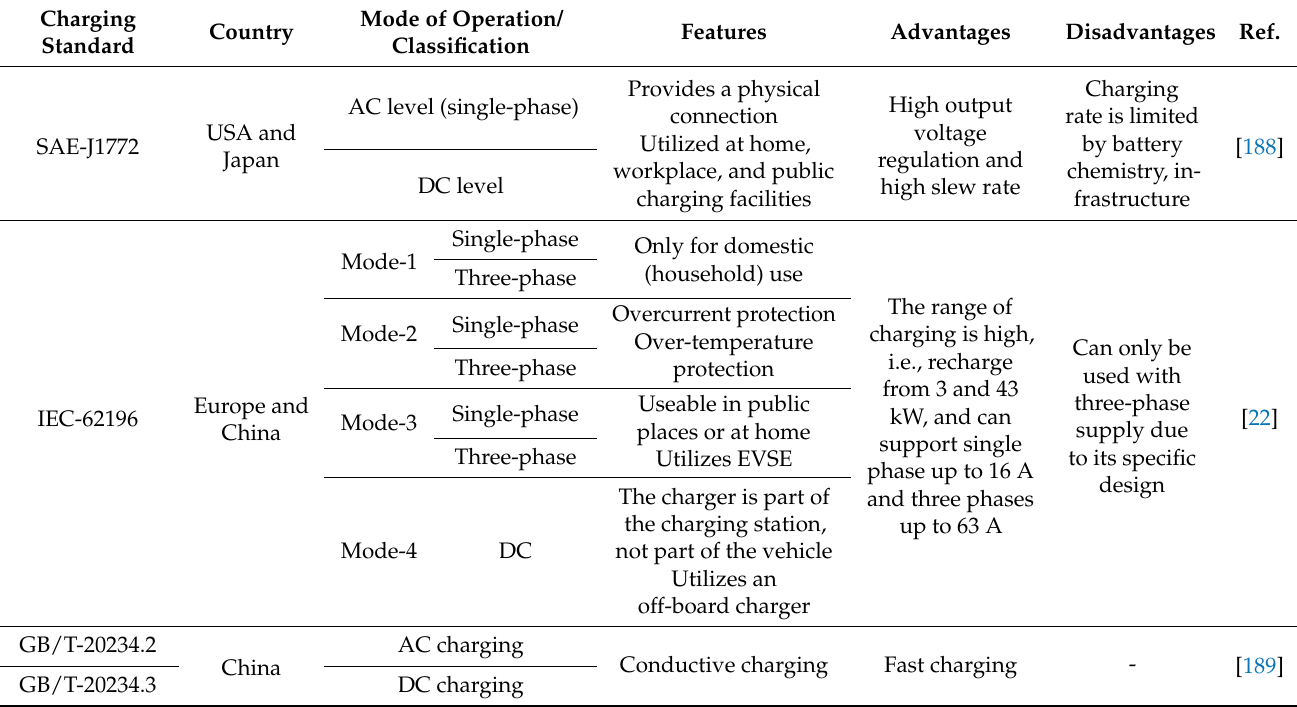
Table 4. Comparative study of various conductive charging standards for EV